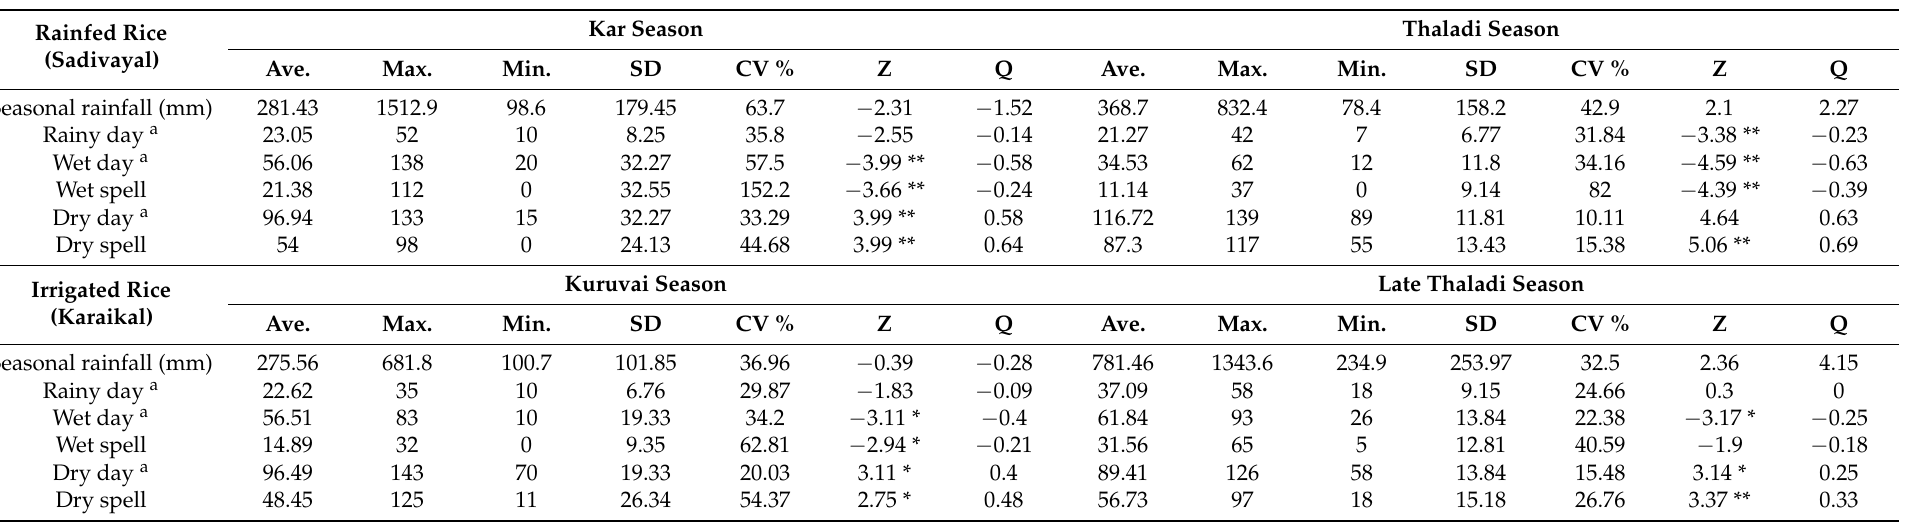
Table 2. Rainfall pattern during major rice-growing seasons in Sadivayal and